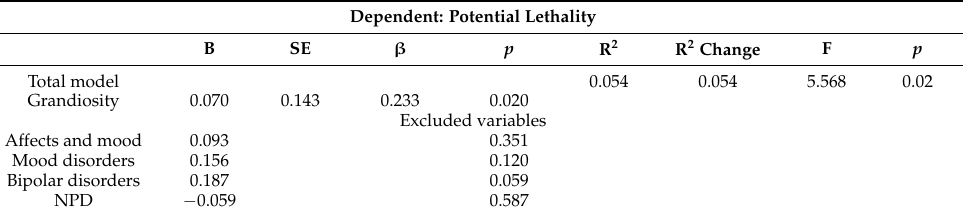
Dependent: Potential